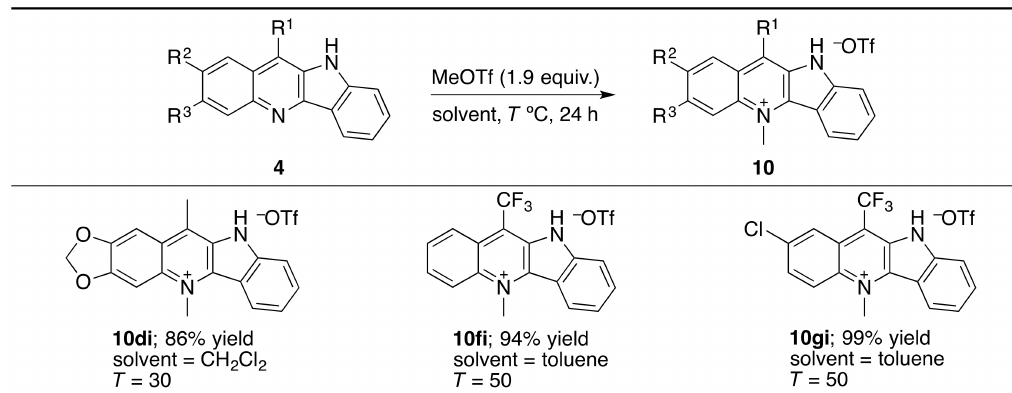
Figure 3. Anti-malarial, antitrypanosomal and anti-cancer activities of cryptolepine, 11-methylcryptolepine, and their HOTf adducts [82]. Table 6. N -Methylation of indolo[3,2- b ]quinolines with MeOTf a